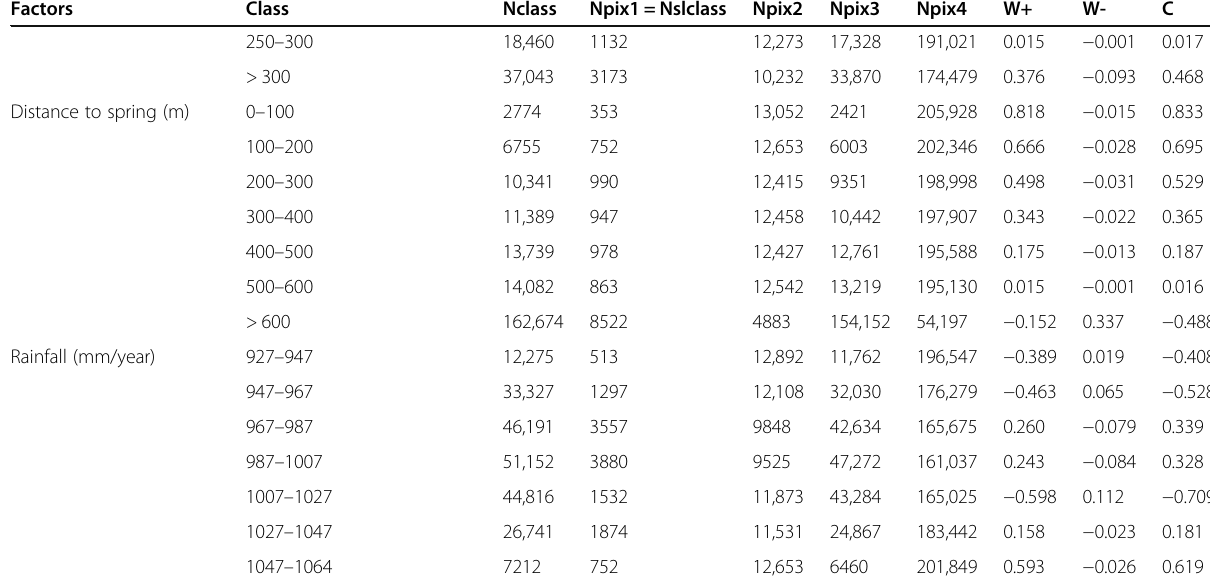
Table 1 The input data used in the analyses and results obtained from Weights of Evidence model (Continued)